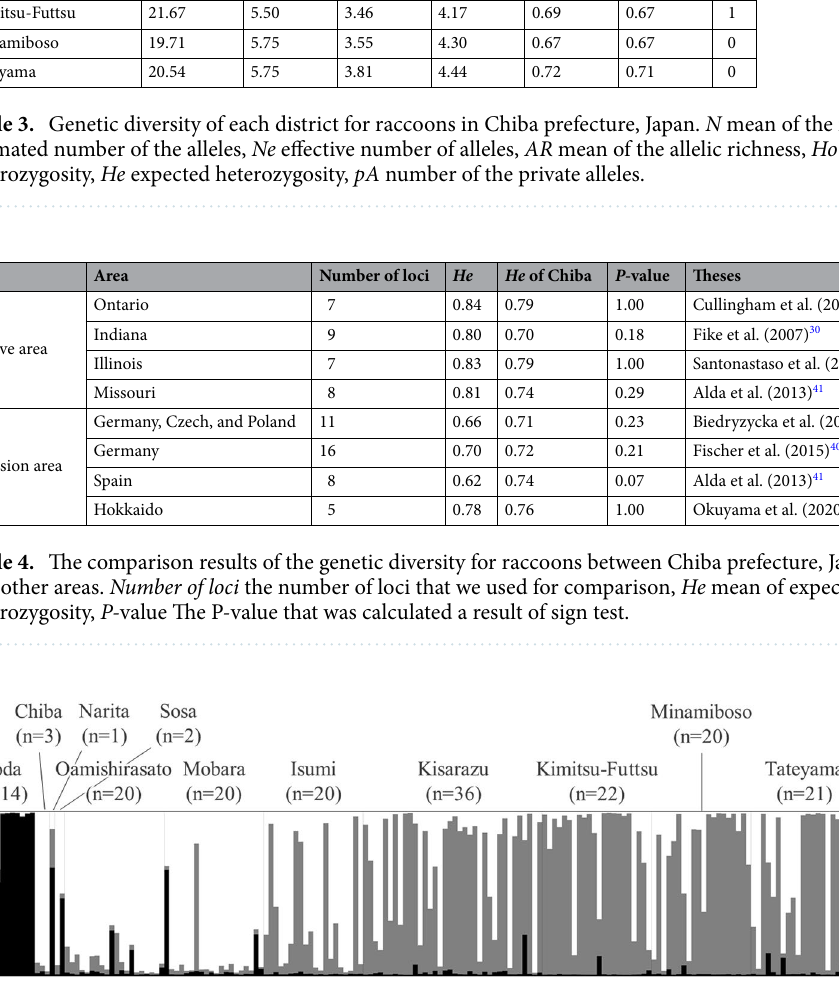
Figure 4. The fraction of the cluster was estimated by STRU CTU RE (K = 3). The individuals are expressed in one bar. The color of cluster I is black, cluster II is grey and cluster III is white. The length of color bars expresses a fraction of the cluster ( Q value).